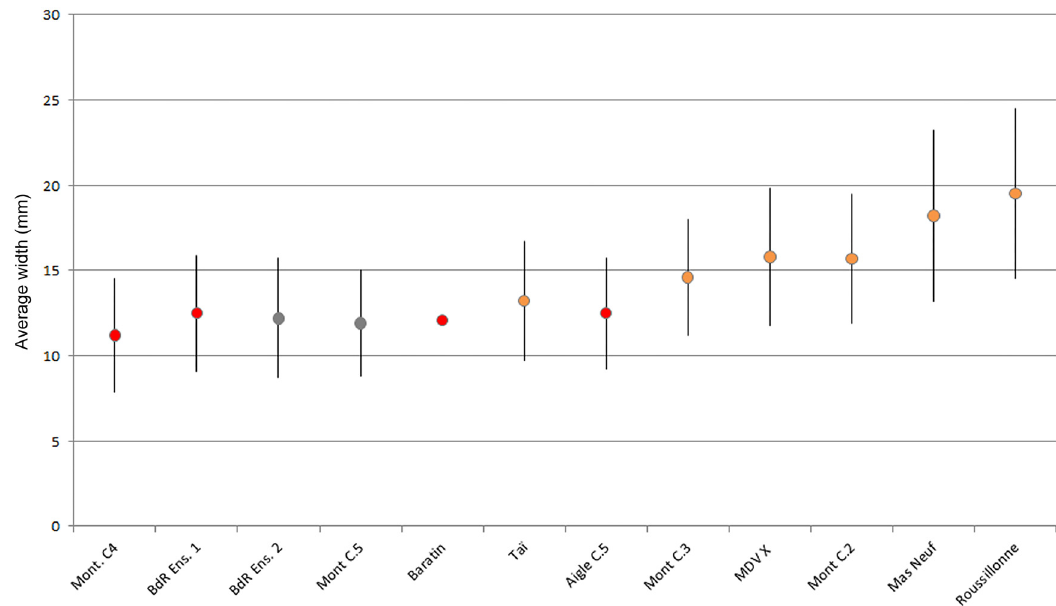
Figure 5: Evolution of the average widths and standard deviations of laminar blanks throughout time. Assemblages attributed to the Cardial in red, Epicardial in orange. Mont. Montclus, BdR: Baume de Ronze, MdV: Mas de Vignoles, Rouss.: Roussillonne. Metric data from Binder, 1987, Defranould, 2019, and Perrin, 2014.